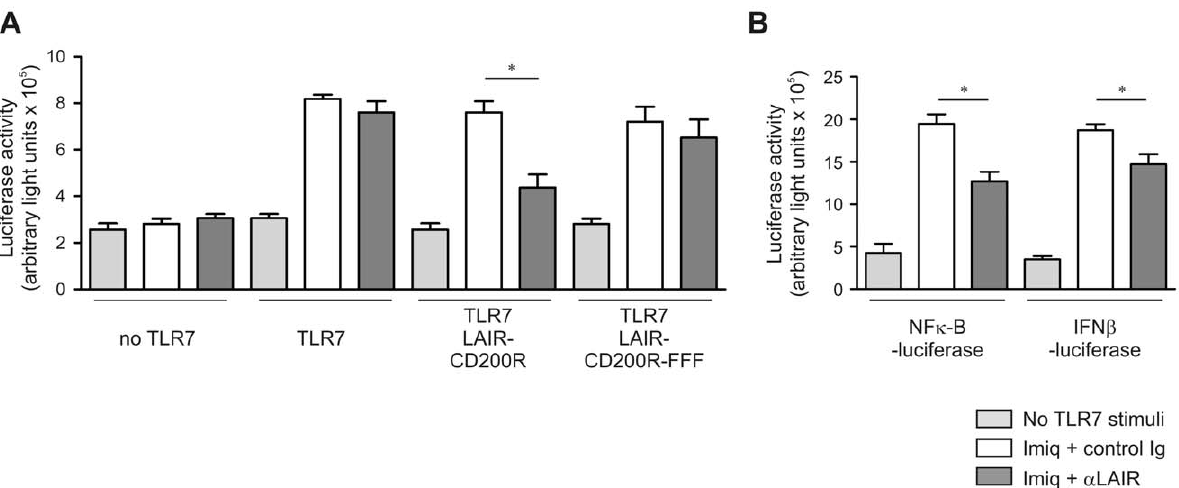
Figure 3. Stimulation of CD200R directly inhibits TLR mediated NF k B activity. A HEK 293 T cells were transiently transfected with TLR7, NF- k B luciferase reporter and LAIR-1-CD200R chimera or signaling-defective LAIR-1-CD200R-FFF constructs. Twenty-four hours later cells were stimulated with control or anti-LAIR-1 antibody. Forty-eight hours after transfection cells were stimulated with the TLR7 ligand imiquimod (3.0 m g/ml). Seventy- two hours after transfection cells were harvested, luciferase activity, and total protein content were determined. Protein normalized, luciferase activity from 3 independent experiments is shown. B HEK 293 T cells with stable expression of TLR7 were transiently transfected with a NF- k B luciferase reporter construct or an IFN b luciferase reporter construct and a LAIR-1-CD200R chimera. TLR7 stimulation and CD200R crosslinking was performed as in (A). Protein normalized with luciferase activity from 3 independent experiments is shown. Mean 6 SEM is shown. Statistical significance was calculated with Mann-Whitney test. ns=not significant. *=p ,